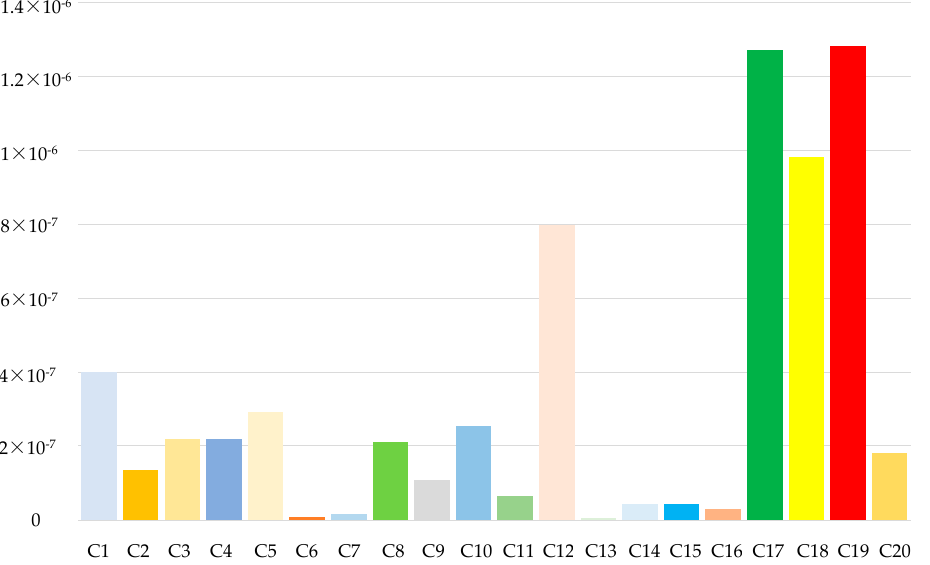
Figure 5. Integrated importance measure results of the bottom events.